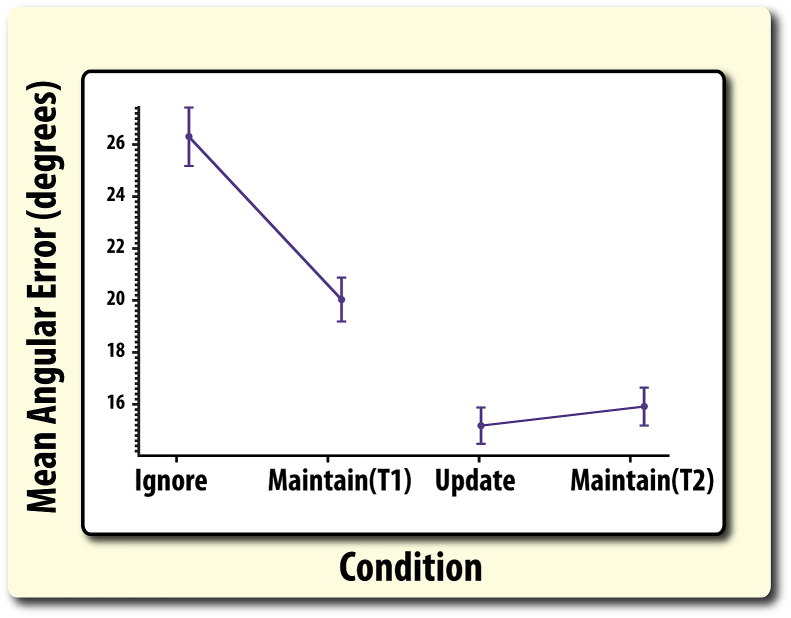
WM recall (mean angular error) according to task. Ignoring irrelevant information led to the greatest error in recall, even when comparing it to a matched unfilled retention duration (Maintain T1). Updating contents of WM led to no significant cost compared to its matched shorter temporal duration (Maintain T2). Error bars reflect standard error of the mean (SEM).